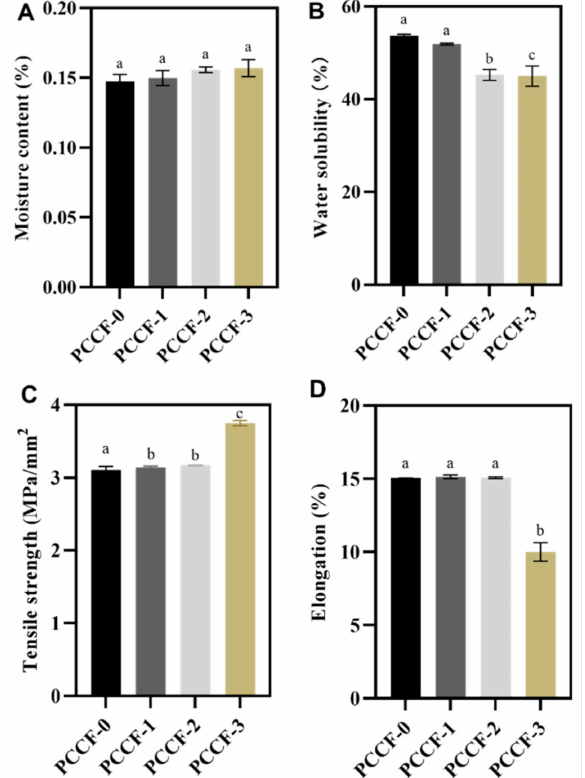
Figure 1. The physical properties of PCCF: ( A ) moisture content; ( B ) water solubility; ( C ) tensile strength; ( D ) the elongation of PCCF. Different letters denote statistically significant